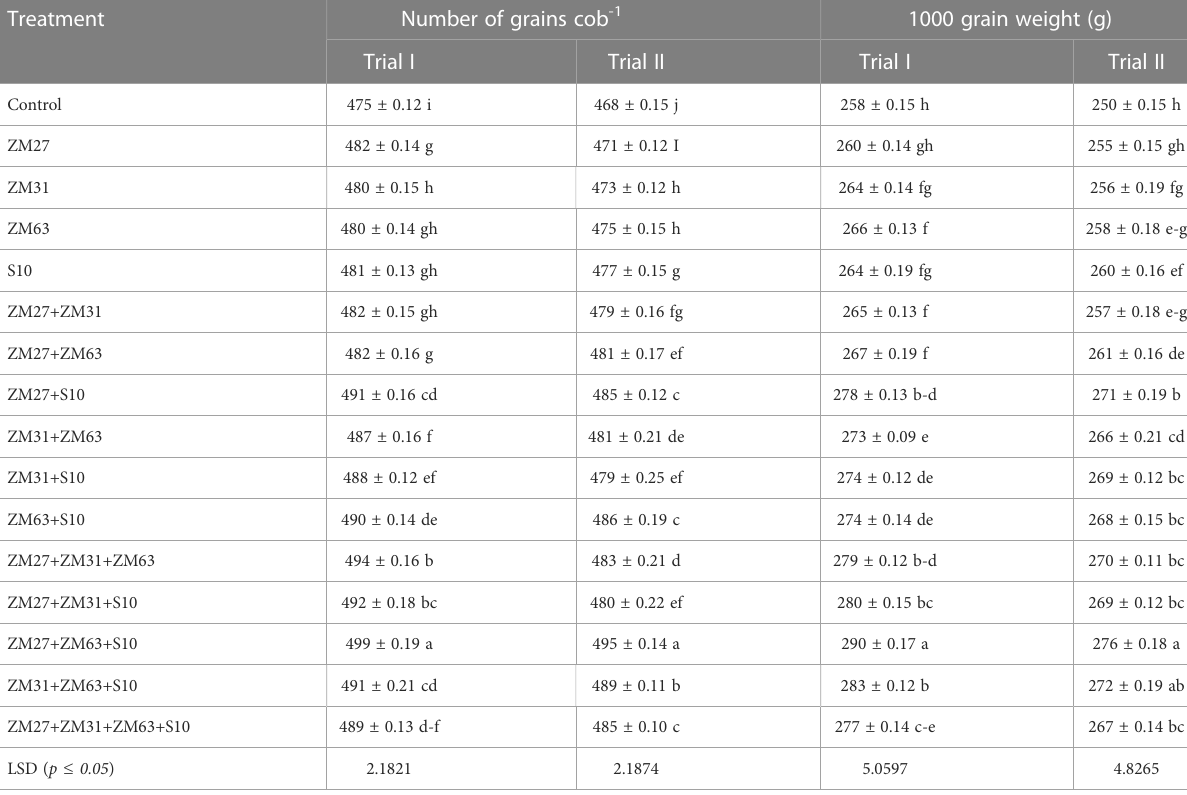
TABLE 5 Effect of novel bio inoculants on grain number and weight of maize in fi eld trials.